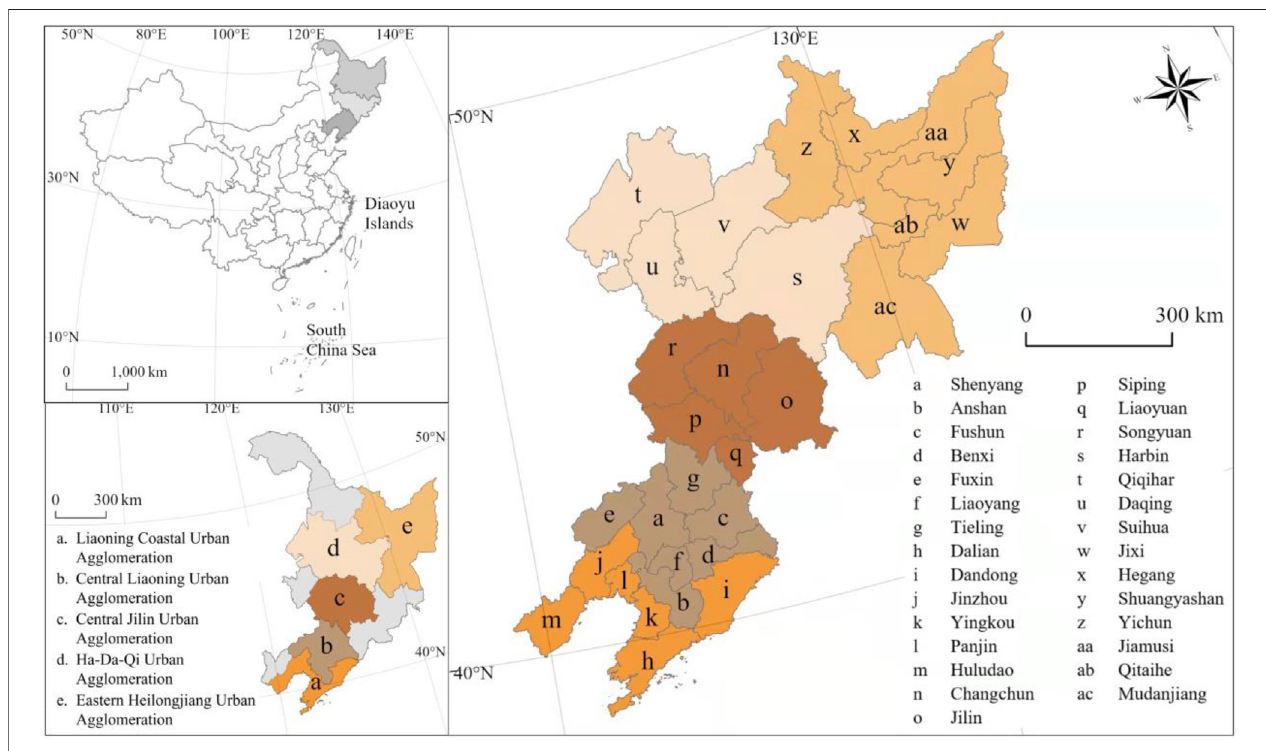
FIGURE 1 | Administrative division map of the urban agglomerations.